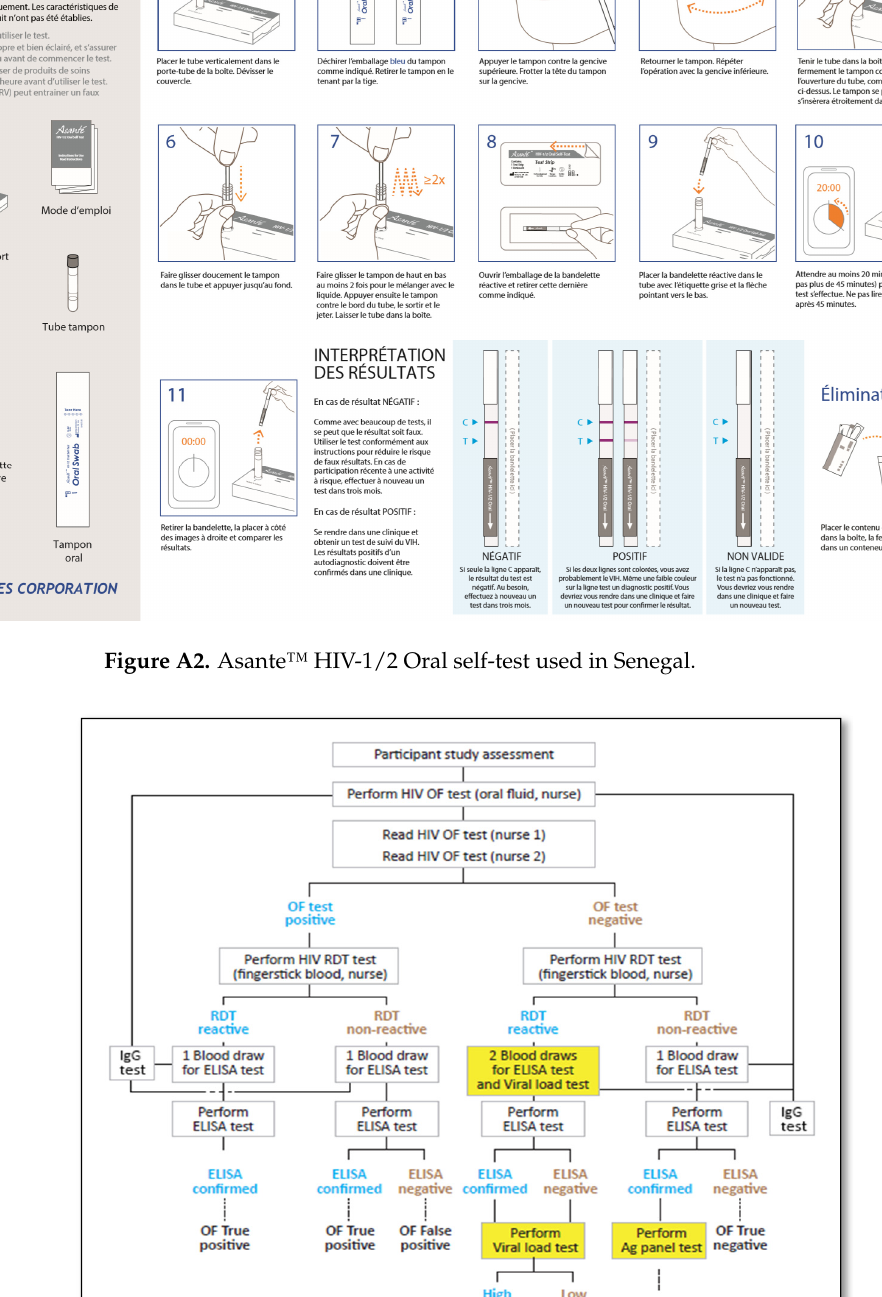
Figure A3. Testing Figure A3. Testing algorithm. Table A1. Research instrument details.